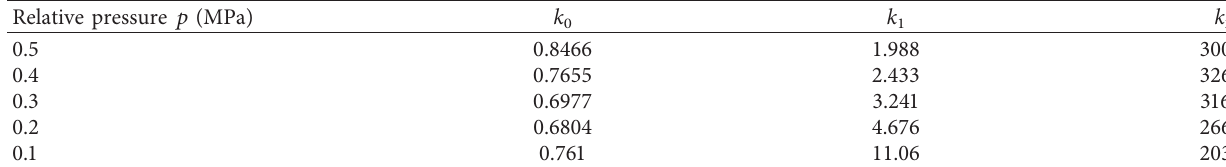
Table 2: The estimated value of the parameter with the PAM